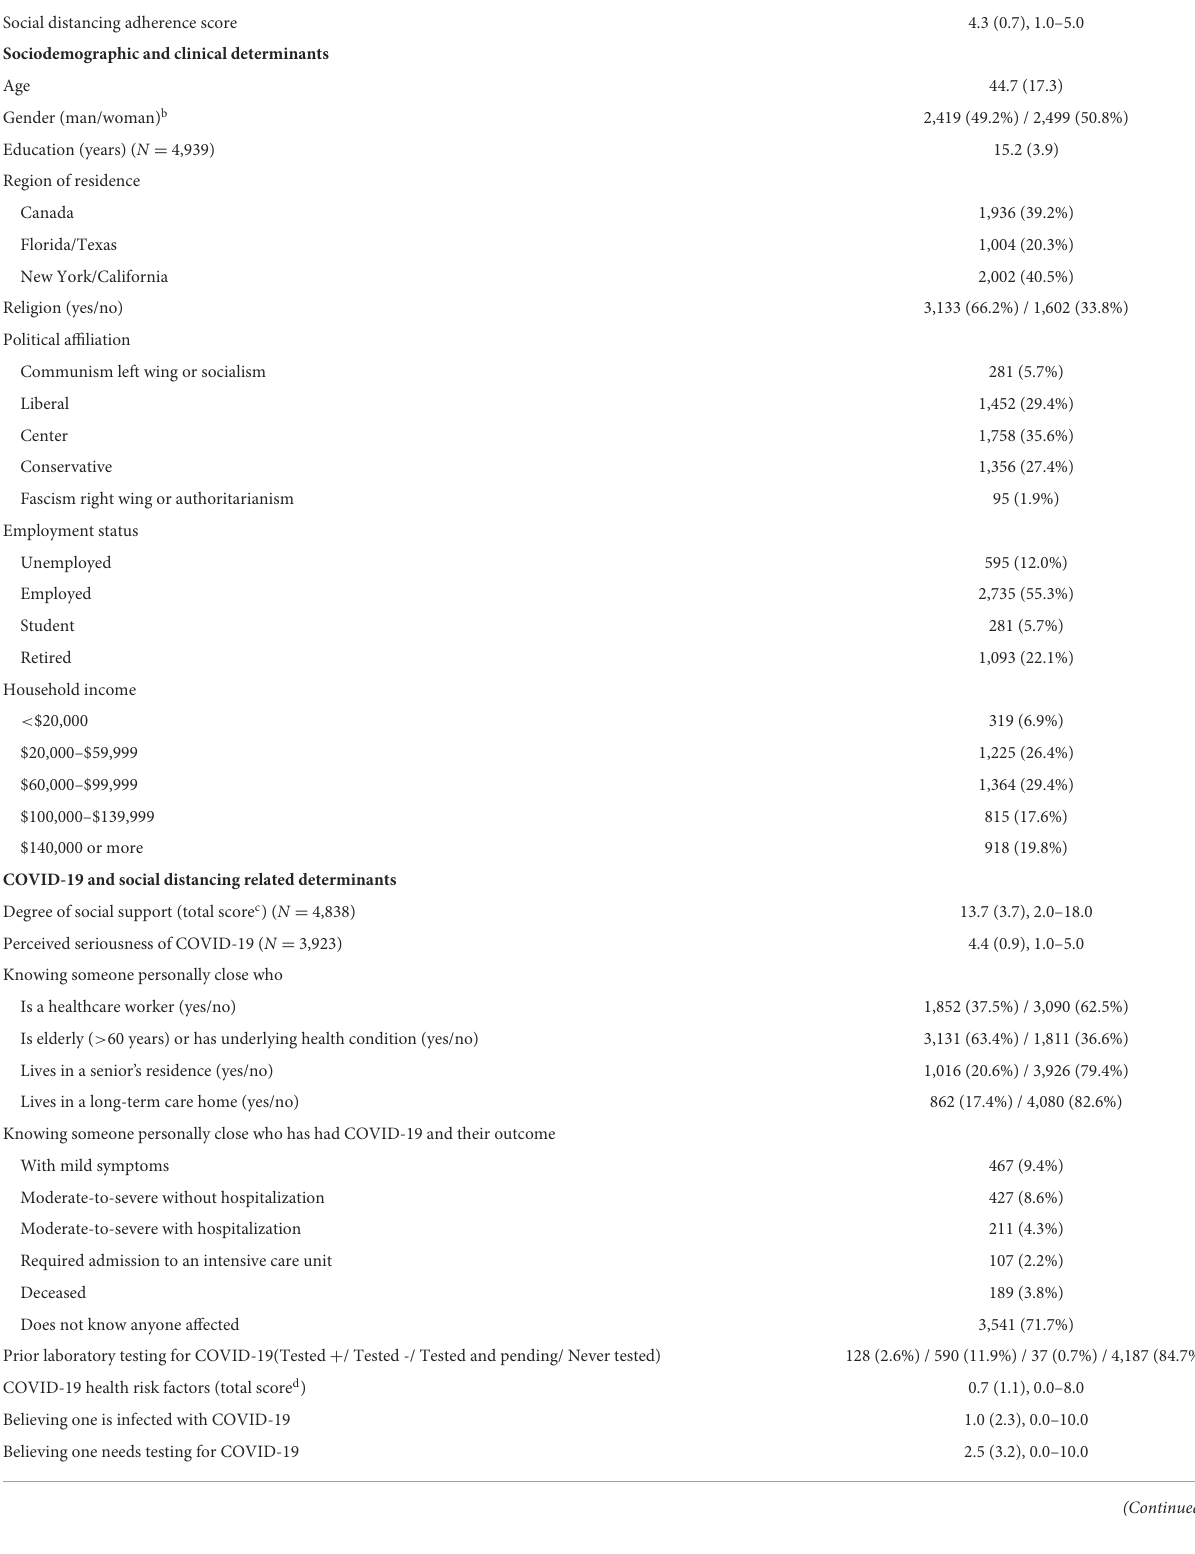
TABLE 1 Participant characteristics including sociodemographic and clinical, COVID-19 and social distancing related, and psychological determinants a